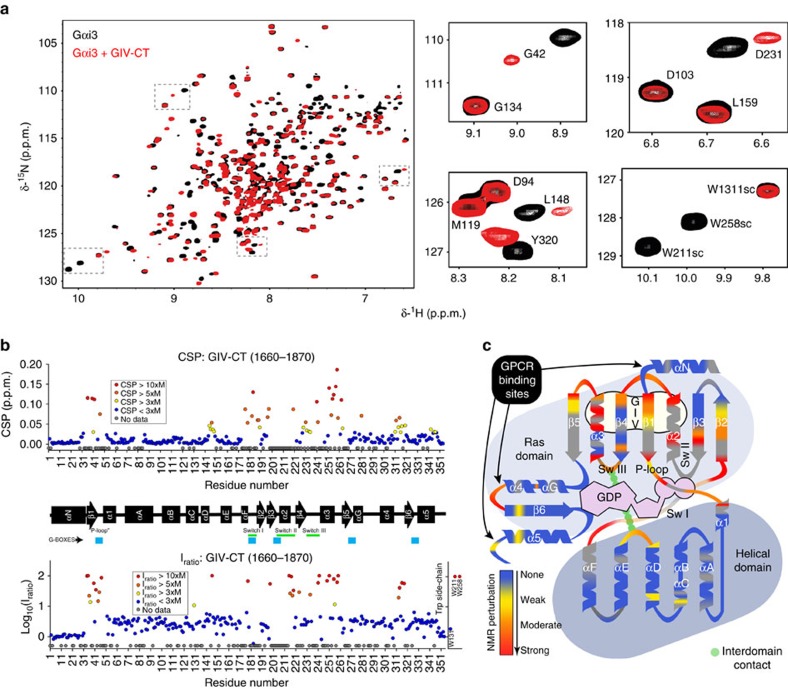
NMR mapping of GIV binding on Gαi3.(a) Overlay of 1H–15N TROSY spectra of Gαi3 free and bound to GIV-CT. Left, 1H–15N TROSY spectra of 2H,13C,15N-Gαi3 in the absence (black) or presence of His-GIV-CT (1660–1870) (red). Right, selected regions from the overlaid spectra depicting representative perturbations in Gαi3 signals induced by GIV binding. Some signals (top) exhibit chemical shift changes on GIV binding. Some other signals (bottom) exhibit marked signal intensity reductions on GIV binding (see text for interpretation). (b) Quantification of GIV-induced perturbations of the NMR signals of Gαi3. Chemical shift (CSP, top graph) or intensity perturbations (Iratio,=Ibound/Ifree, bottom graph) of the backbone amide signals of the TROSY NMR spectra in a. Red, orange and yellow circles indicate residues undergoing perturbations larger than 10, 5 or 3 times the median (M), respectively. Blue circles indicate Gαi3 residues with perturbations smaller than three times the median (M) and grey circles residues for which no reliable NMR measurement could be made. The horizontal black bar in the middle depicts the secondary structure elements of Gαi3 derived from our homology model (see below), and is annotated with the position of the three switch regions (green) that undergo conformational changes on GTP binding and the five conserved G-box sequences (blue) that mediate nucleotide binding. (c) Schematic representation of GIV-induced NMR perturbations on Gαi3. Gαi3 secondary structure elements are depicted with a relative orientation to mimic their position with respect to the nucleotide in the three-dimensional structure. Colour coding is the same as in b and corresponds to a composite of CSP and Iratio perturbations. For residues in which information for both CSP and Iratio perturbations was available, the largest of the two was taken. GDP is shown in purple and the interaction between the Switch III of the Ras-like domain and the αD–αE loop of the all-helical domain is shown in green. The GIV-binding region predicted by modelling is shown in light beige and the GPCR-binding elements are marked by arrows.